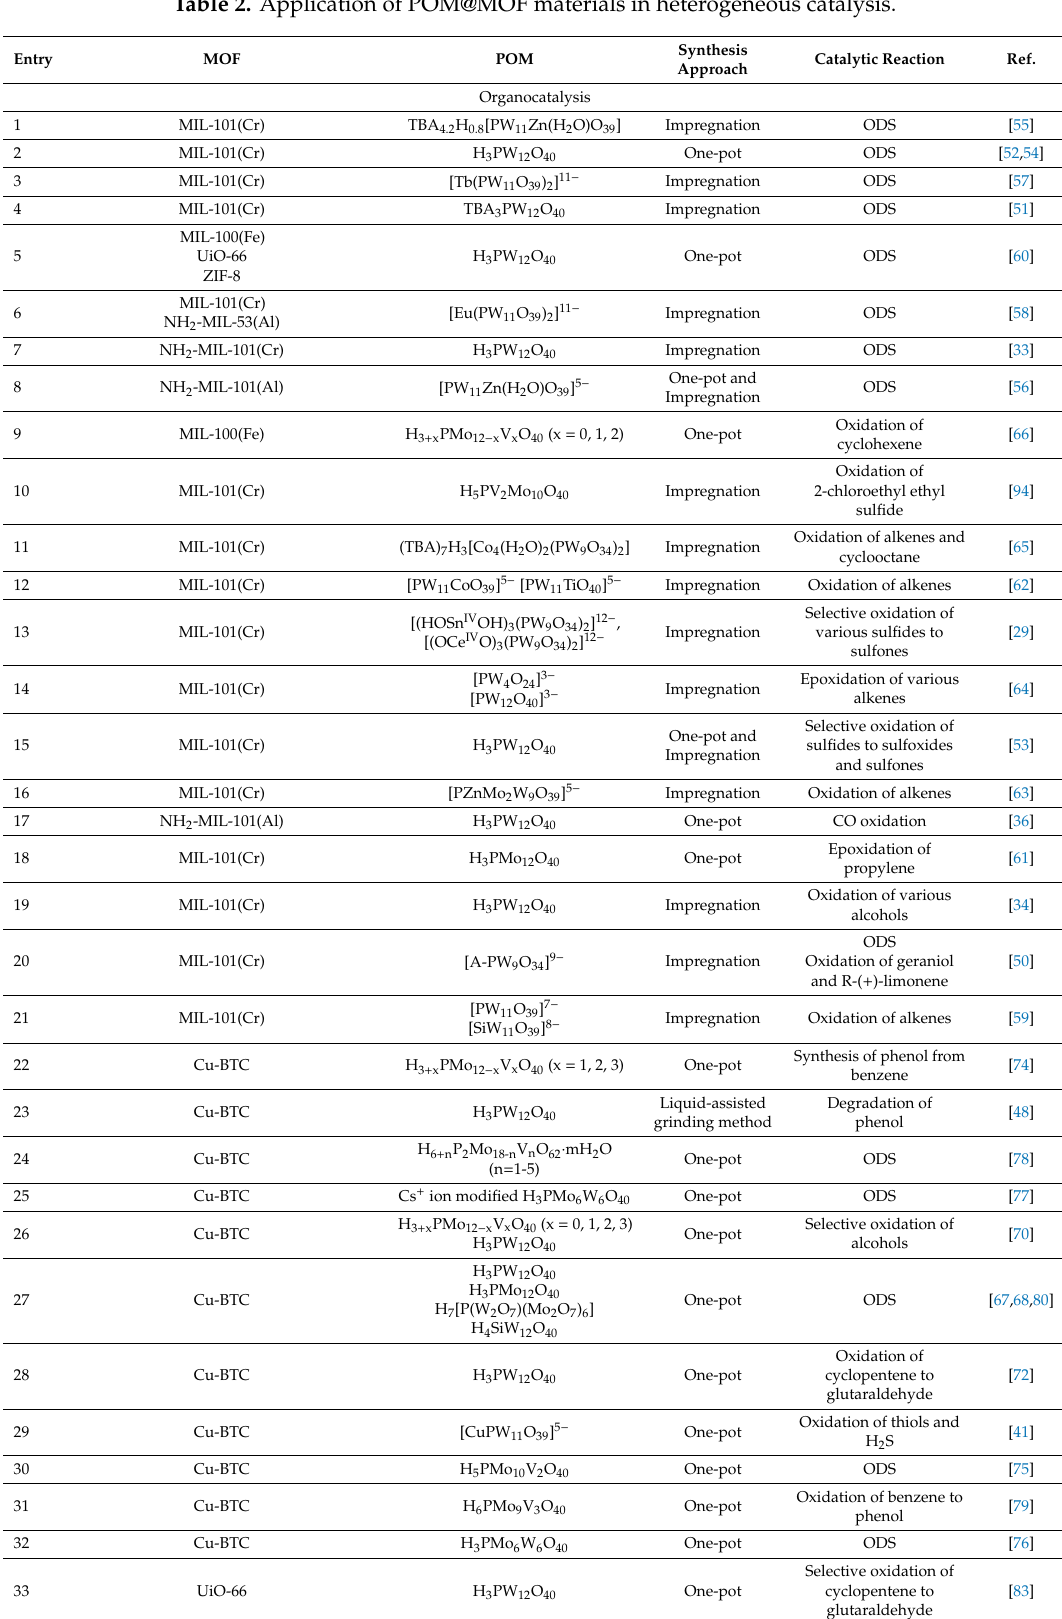
Table 2. Application of POM@MOF materials in heterogeneous